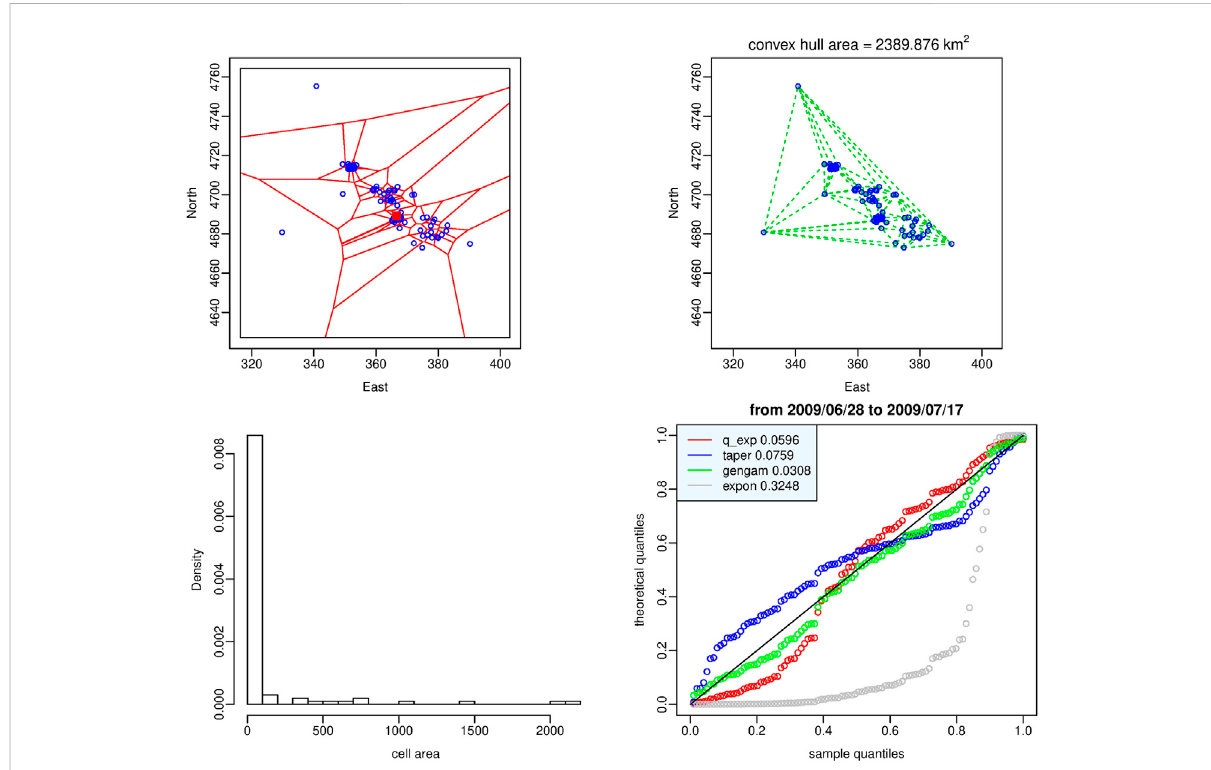
FIGURE 6 Dataset of the time window in which the generalized gamma distribution provides the best fi t. Top: Voronoi tessellation (left-hand panel) and Delaunay triangulation (right-hand panel). Bottom: histogram of the cell areas (left-hand panel) and Q-Q plot of the four probability distributions (right-hand panel). Red square indicates the epicenter of L ’ Aquila